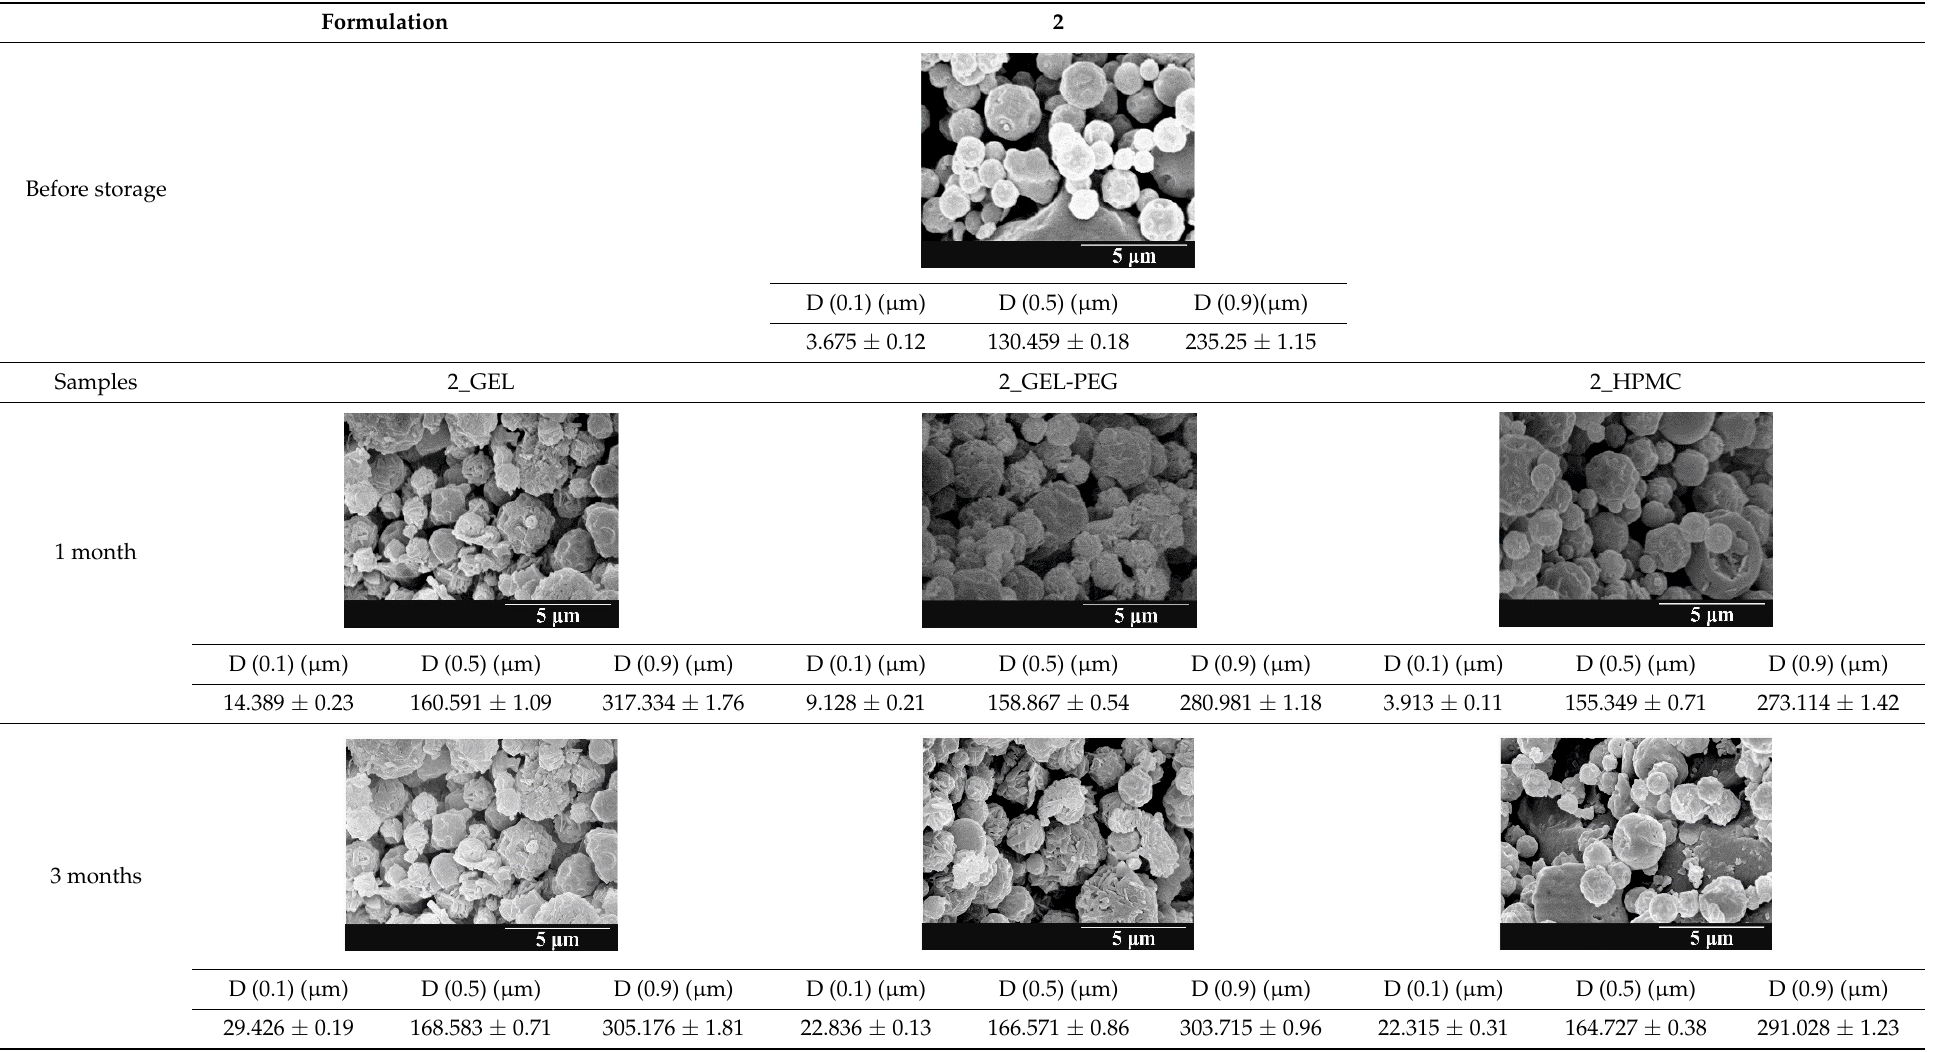
Table 6. Particle size distribution and morphology of the novel combined carrier-based samples during the stability test. Formulation